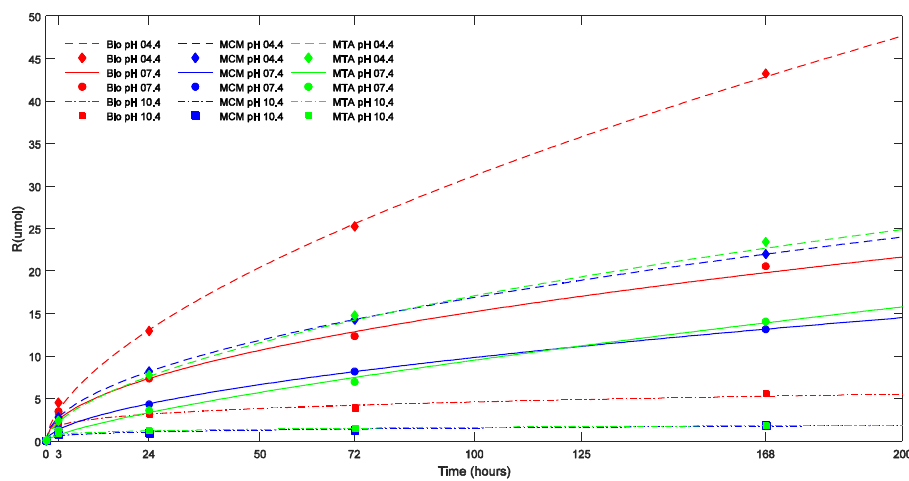
Figure 2. Effect of pH on the cumulative calcium ion release (R) of the TSCs studied (in μmoles) as a function of time. The points represent the measured values and the lines show the calculated values according to Equation (1). Bio: Biodentine™; MCM: Medcem MTA ® ; MTA: ProRoot ® white MTA.